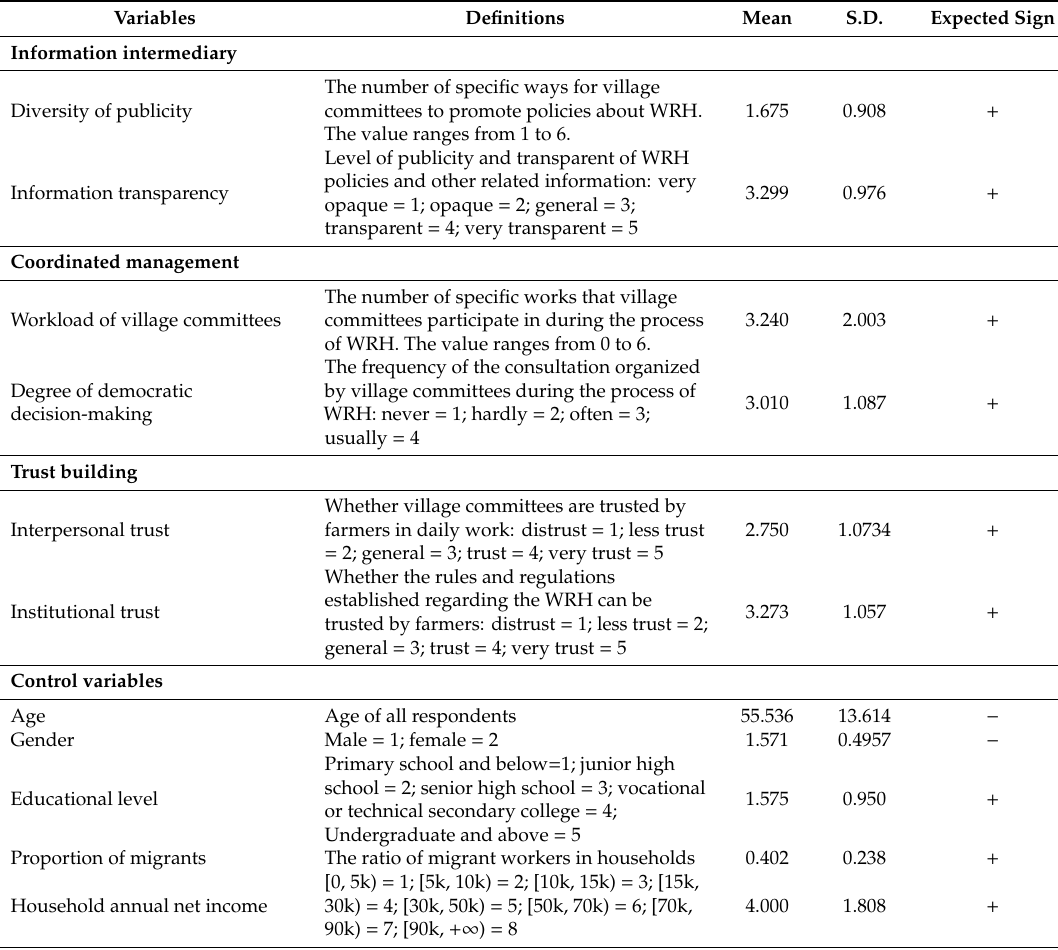
Table 2. Definition and descriptive statistics of each